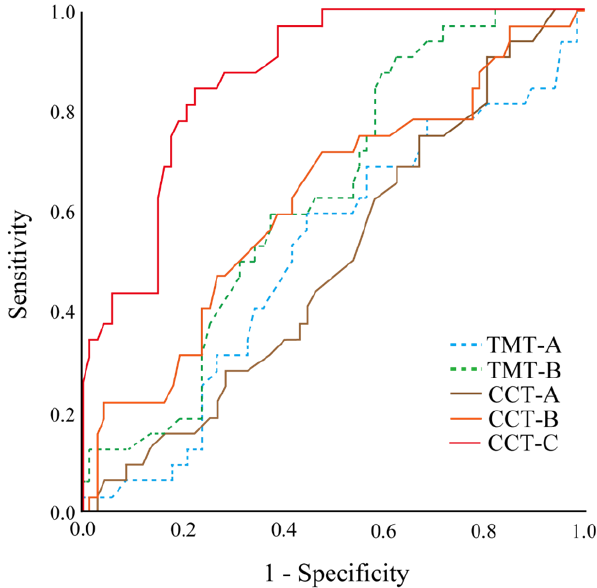
Figure 5. Receiver operating characteristic (ROC) curves of each neuropsychological test. ROC curves predicting HC or MCI with the TMT-A, TMT-B, CCT-A, CCT-B, and CCT-C (time). HC, healthy control; MCI, mild cognitive impairment; TMT-A, Trail Making Test Part A; TMT-B, Trail Making Test Part B; CCT, Cognitive Composition Test. Table 2. ROC curves of each neuropsychological test. AUC p -Value Cut-Off Sensitivity Specificity